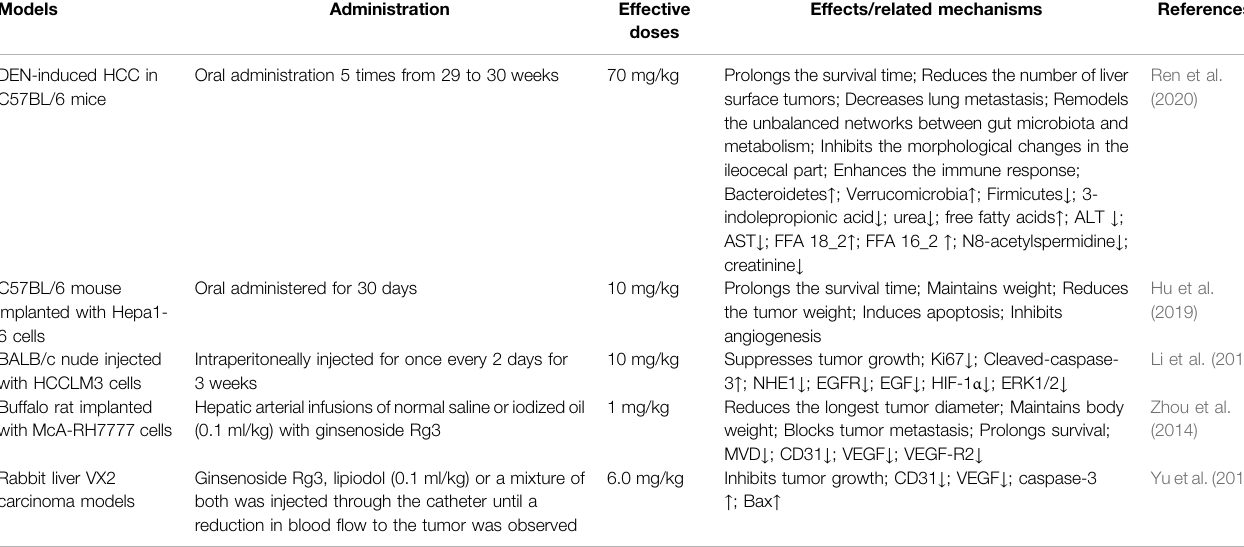
TABLE 8 | Biological effects of ginsenoside Rg3 on in vivo models of